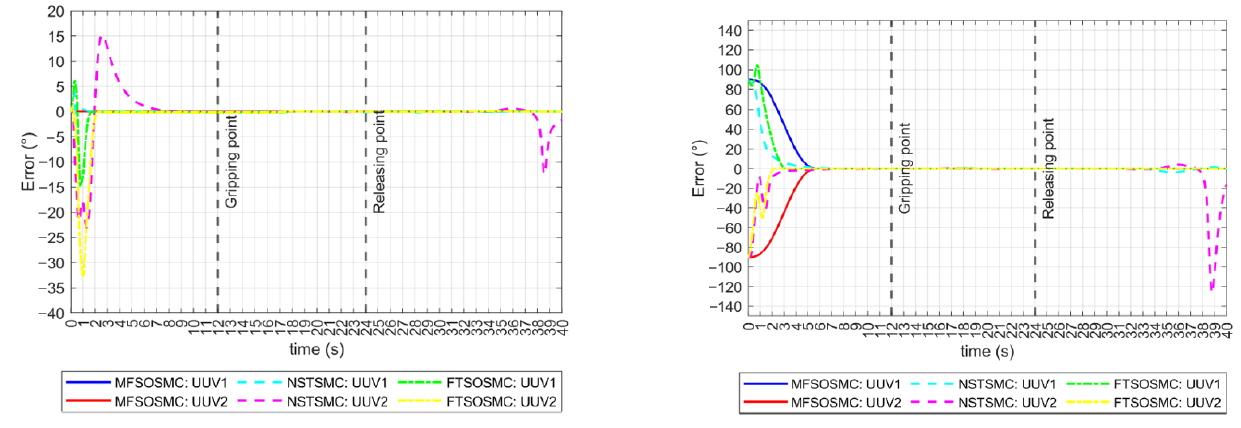
Figure 14. Tracking error for all the controllers (with external disturbances). Left : 𝜙 orientation. Right : 𝜓 orientation.